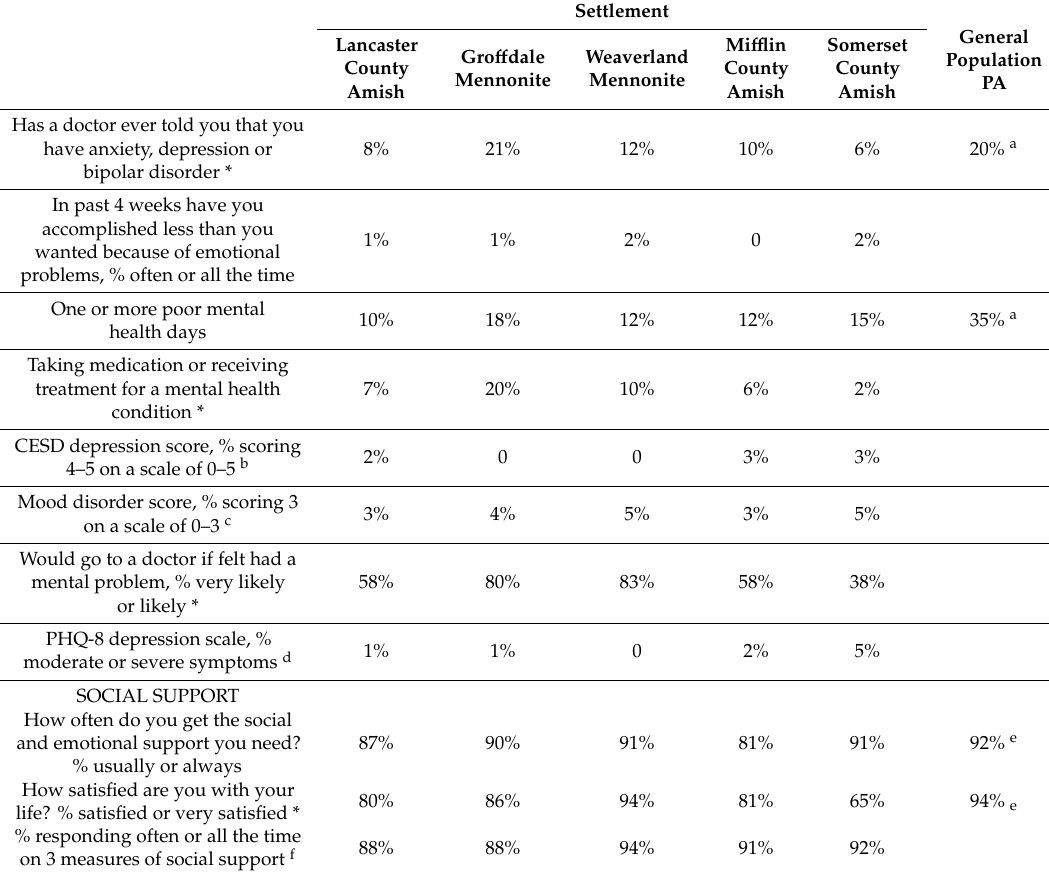
Table 5. Mental health and social support in 5 Pennsylvania Plain communities and the general Pennsylvania population.